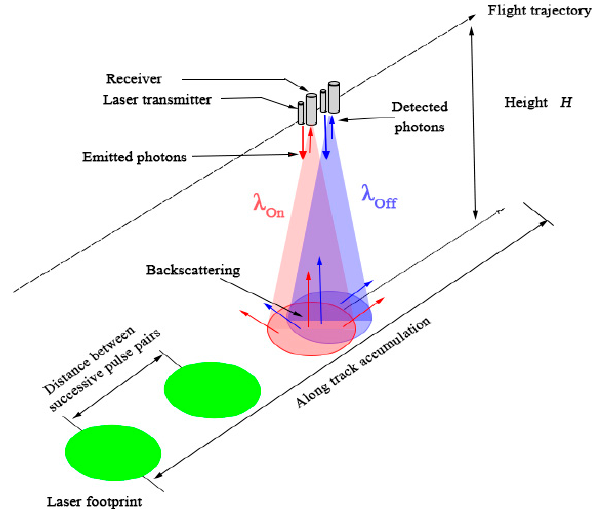
Figure 1. Detection mechanism of the airborne integrated path differential absorption (IPDA) Lidar for detecting CO 2.